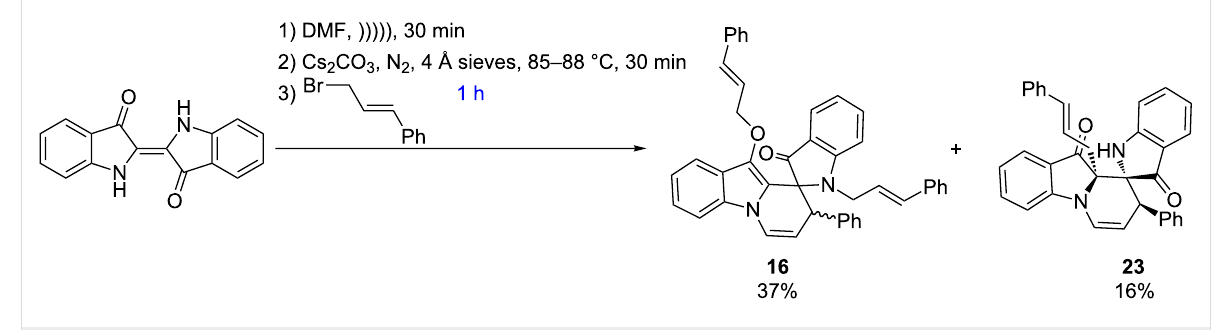
197.8 ppm, assigned to two carbonyl groups. This eliminated the substituent pattern as defined by spiro compounds 12 – 16